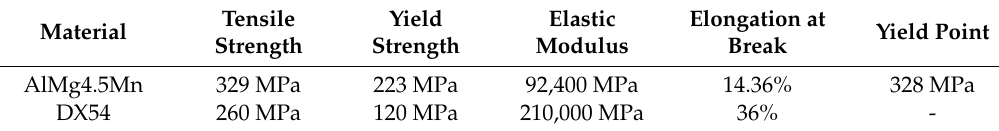
Figure 1. Schematic illustration of the specimen geometry. Table 1. Mechanical properties of the base materials.